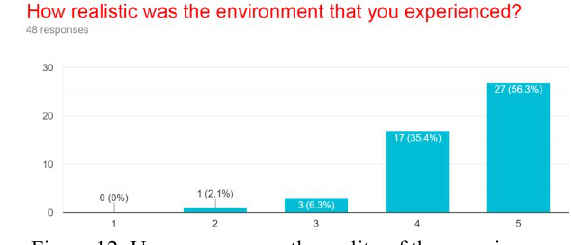
Figure 12: User response on the reality of the experience